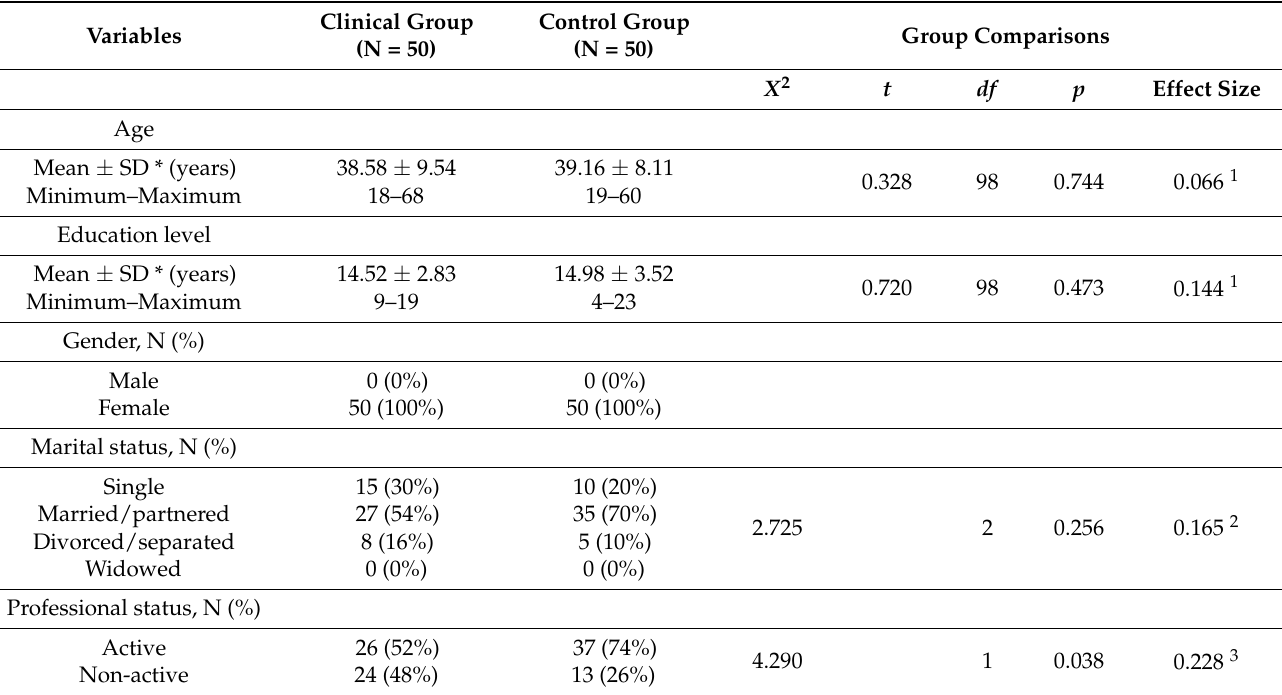
Table 1. Comparison of MS and healthy participants on sociodemographic variables (N =